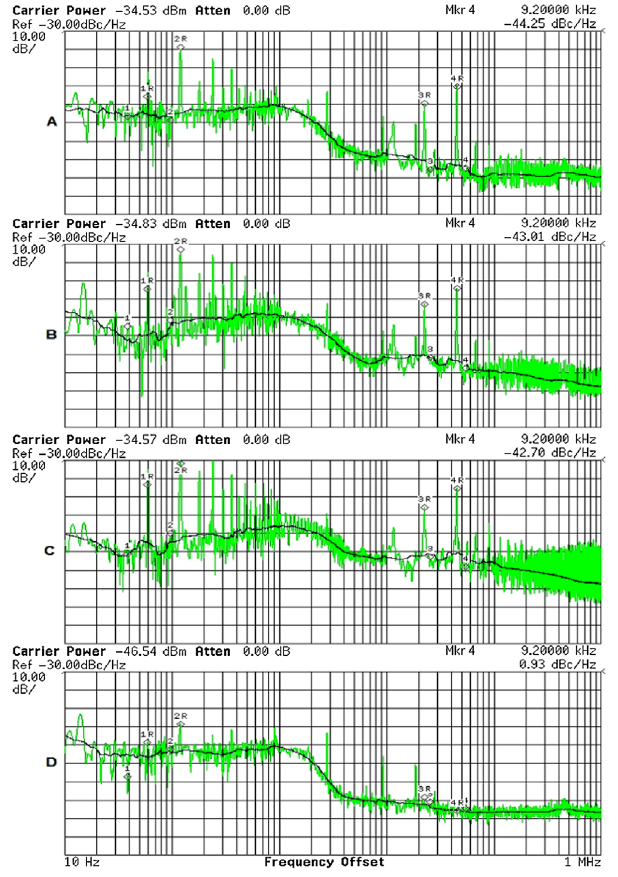
FIG. 6. The spectral power density of the noise of magnetron at the output power of 1 kW, at the power of the locking signal of 100, 30,and10W, traces A, B, and C, respectively[15]. Traces D arethe spectral power density of noise of the injection-locking signal ¼ 100 W), when the magnetron feeding voltage is off. ( P Lock Black traces show the averaged spectral power density of the